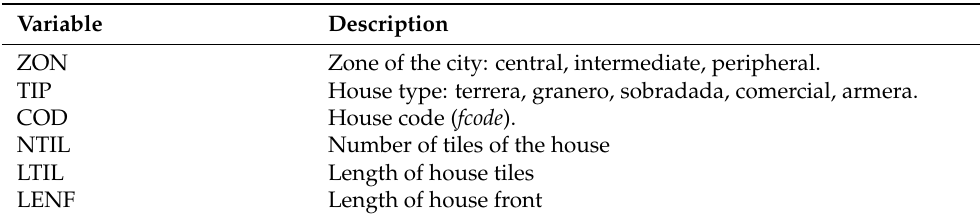
Table 3. Variables of the probabilistic graphical model in Figure